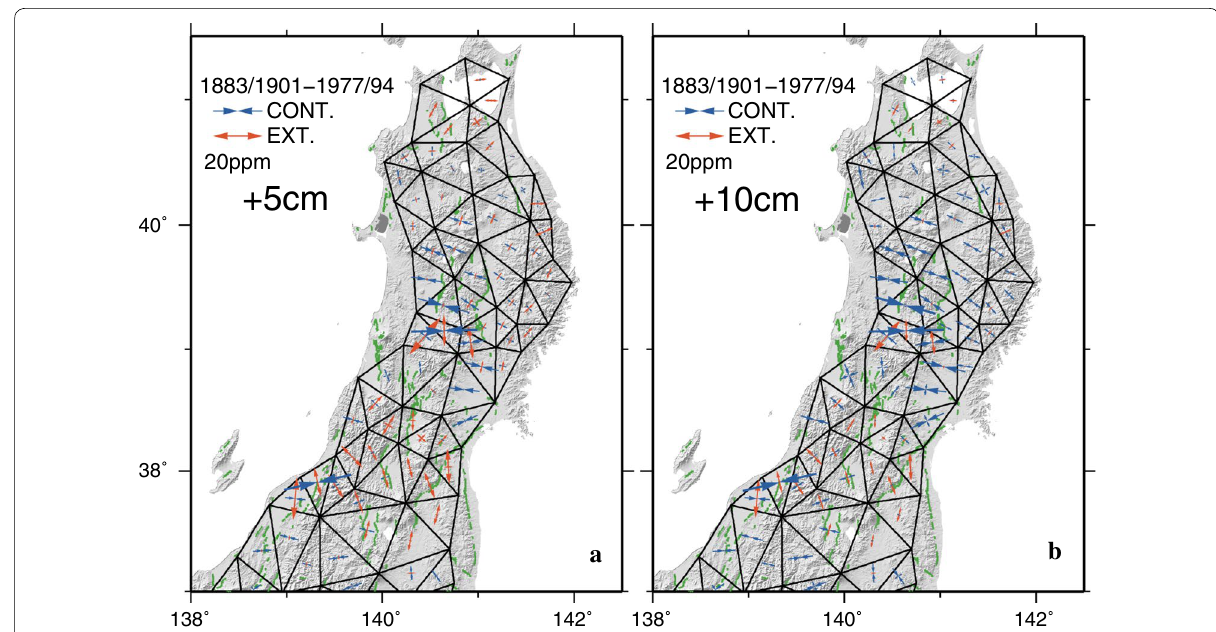
Fig. 7 Crustal strain during the 100 years after correction of scale bias. a Case of